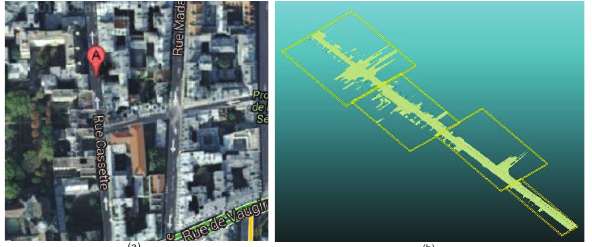
Figure 7: Surface reconstruction results obtained for dataset Ur- ban ♯ 2 . (a) Google street view of the surveyed area, (b) surface re- construction results obtained for 4 chunks with different lengths (each one included in its bounding box), overall approximative distance: 217